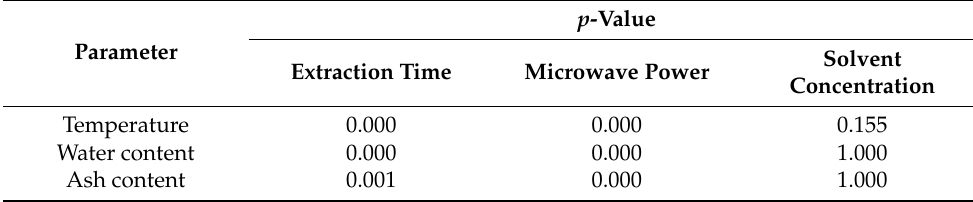
Table 4. Individual regression coefficient test results.